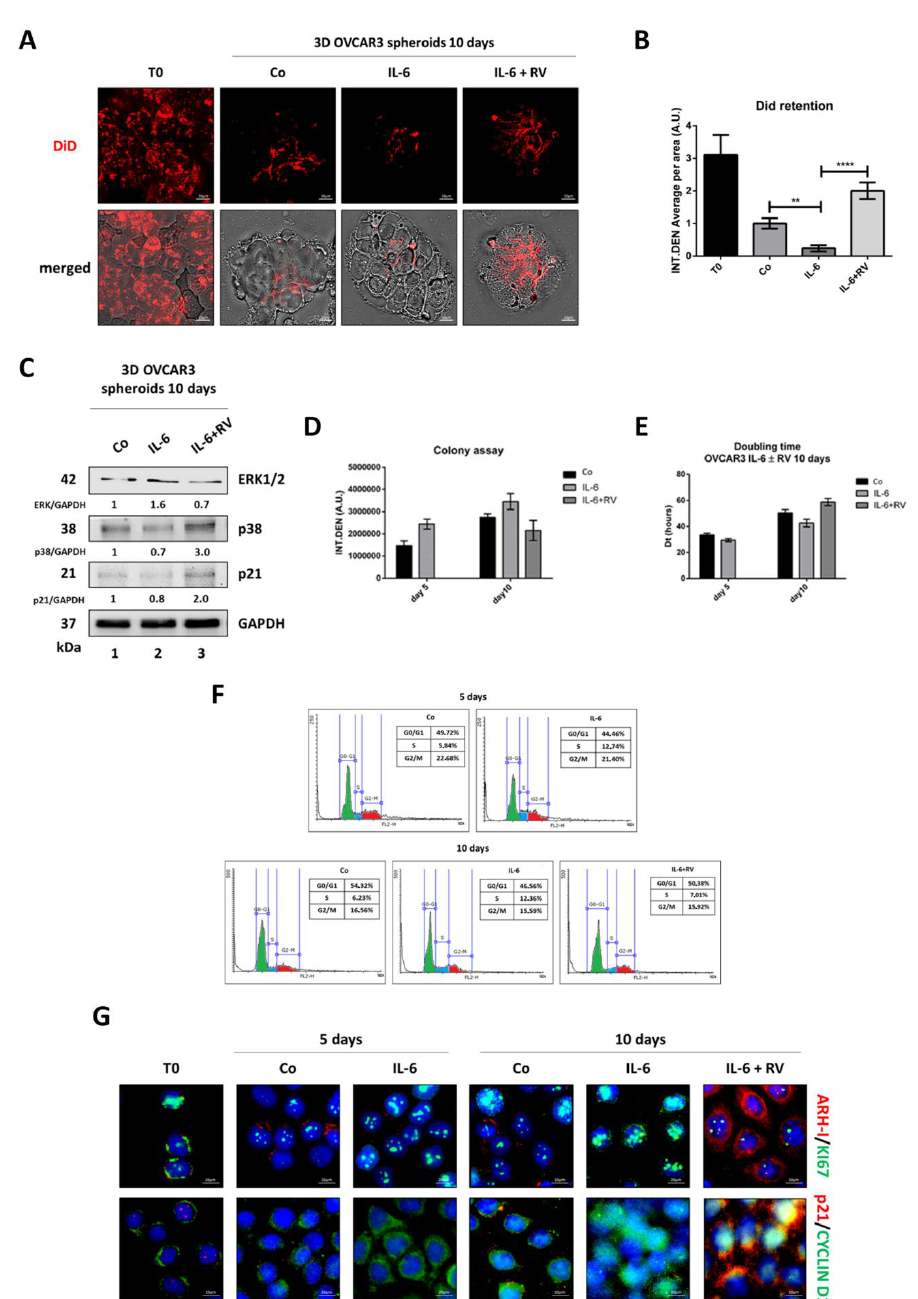
Figure 3. Resveratrol induces dormant-like cell cycle arrest in ovarian cancer spheroids exposed to IL-6. A-B-C. OVCAR3 cells were grown as 3D spheroids and treated following the same timeline as Figure 2. ( A ) The assessment of cell proliferation rate of OVCAR3 3D spheroids. On day 10, DiD- stained 3D spheroids were cytospotted on glass slides and immediately observed under a fluorescence microscope. Scale bar = 20 µ m; magnification = 63 . ( B ) Quantification of DiD dye retention × performed by ImageJ software. Data S.D. represent three independent replicates. Statistical ± analysis was performed by using GraphPad Prism 5.0 software. Bonferroni’s multiple